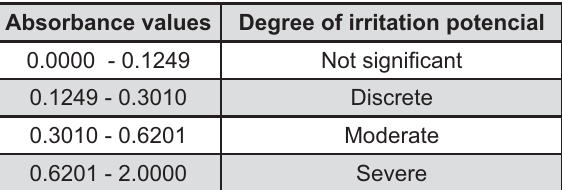
Figura 1- Criteria for evaluating the irritating potential of substances according to the absorbance values (A620) - Nagem-Filho and Pereira 14 Table 1- Mean and standard deviation of optic density reading obtained by the spectrophotometer, corresponding to the degree of irritation - Nagem-Filho and Pereira 14 (1976).